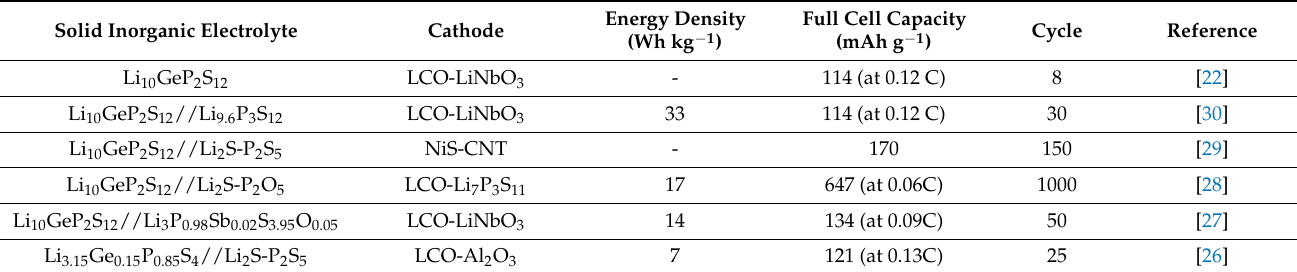
Energy Density Full Cell Capacity Cycle Reference (Wh kg − 1 ) (mAh g − 1 )